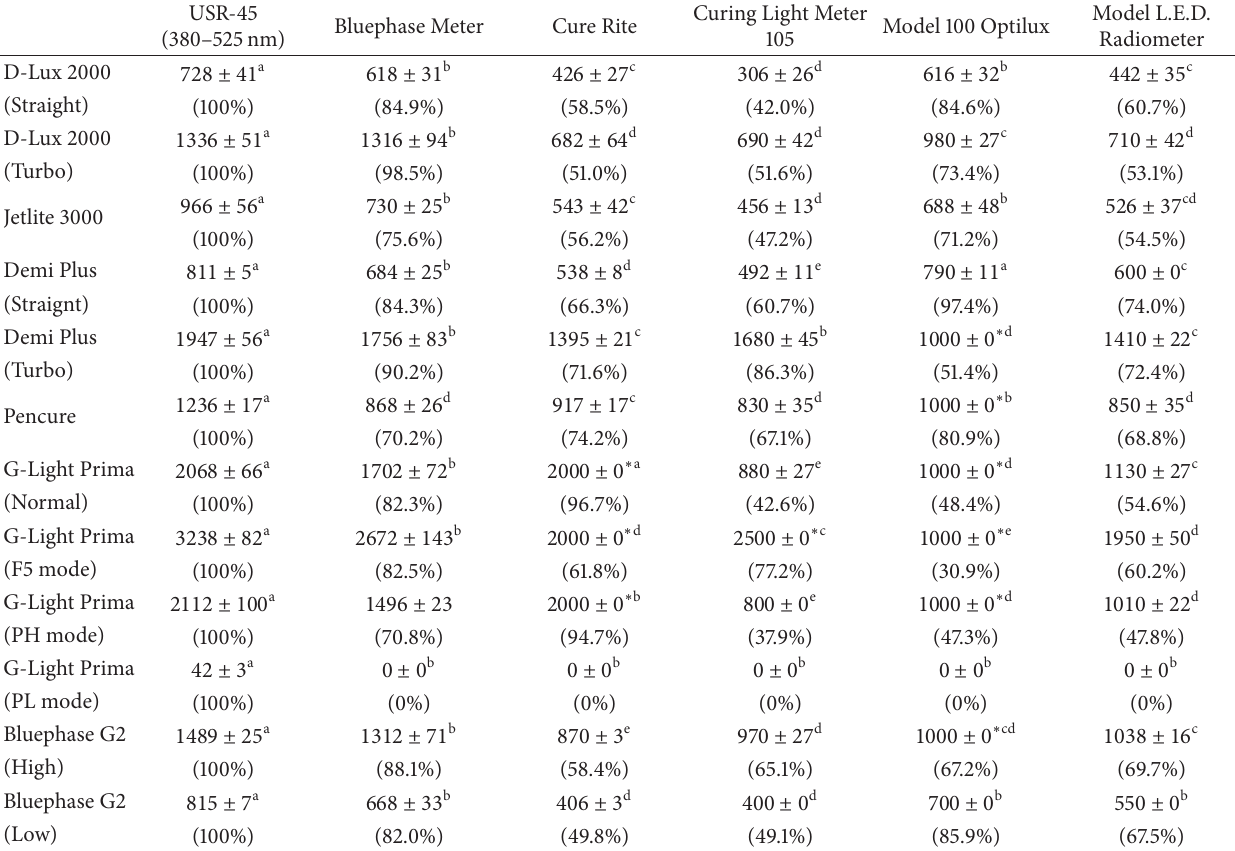
Table 4: Displayed light output (Mean ± S.D.; mW/cm 2 ) and percentage of the reduction from USR-45 (%) ( 𝑛 = 5